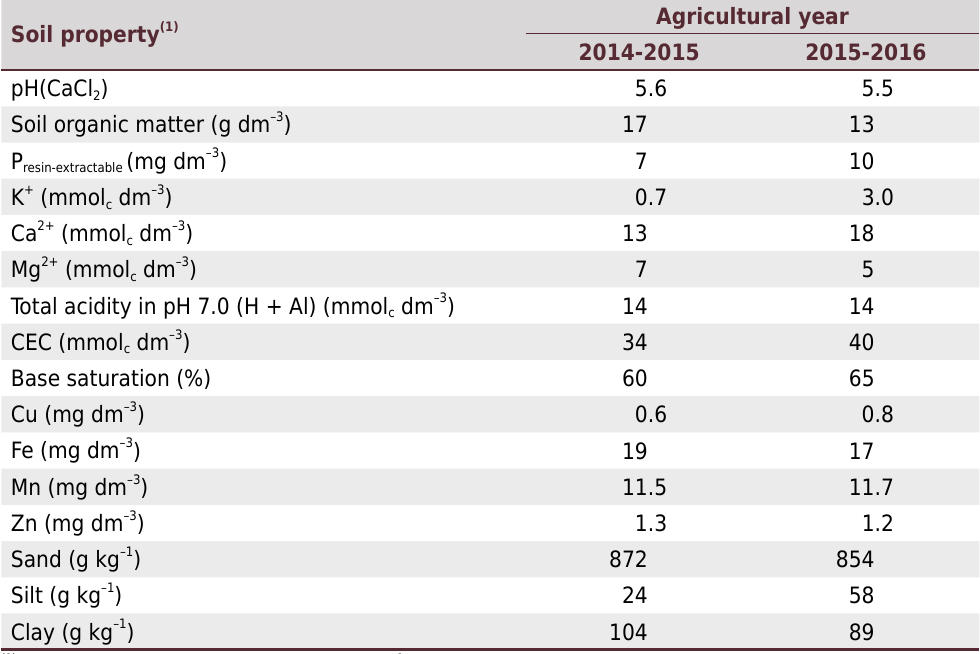
Table 1. Soil chemical and textural properties at the experimental areas before green manure sowing Soil property